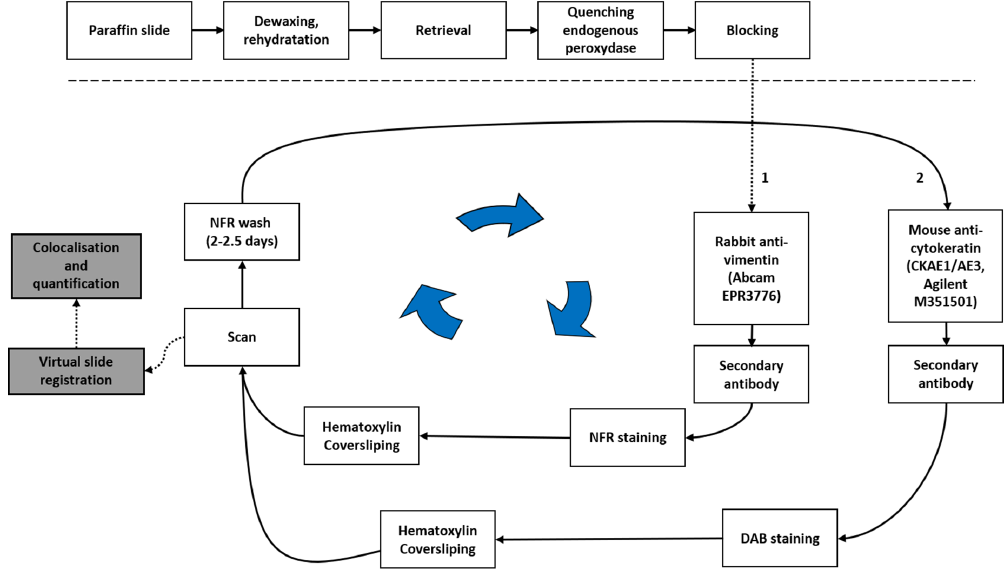
Figure 1. Sequential chromogenic immunohistochemical multiplex (SCIM) to evidence cells co-expressing vimentin (VIM) and pan-cytokeratin (pan-CK). See the main text for details. NFR: napthol and Fast Red; DAB: diaminobenzidine.